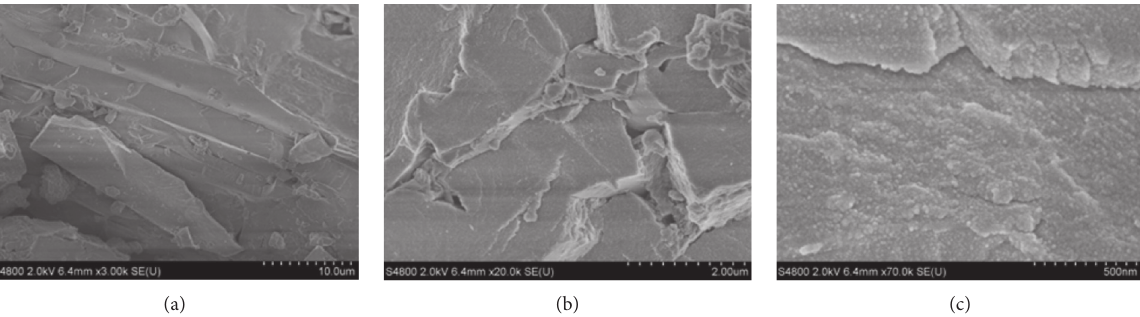
Figure 3: SEM images of samples in Wanli Coal Mine at different magnifications (3000, 20000, and 70000x from left to